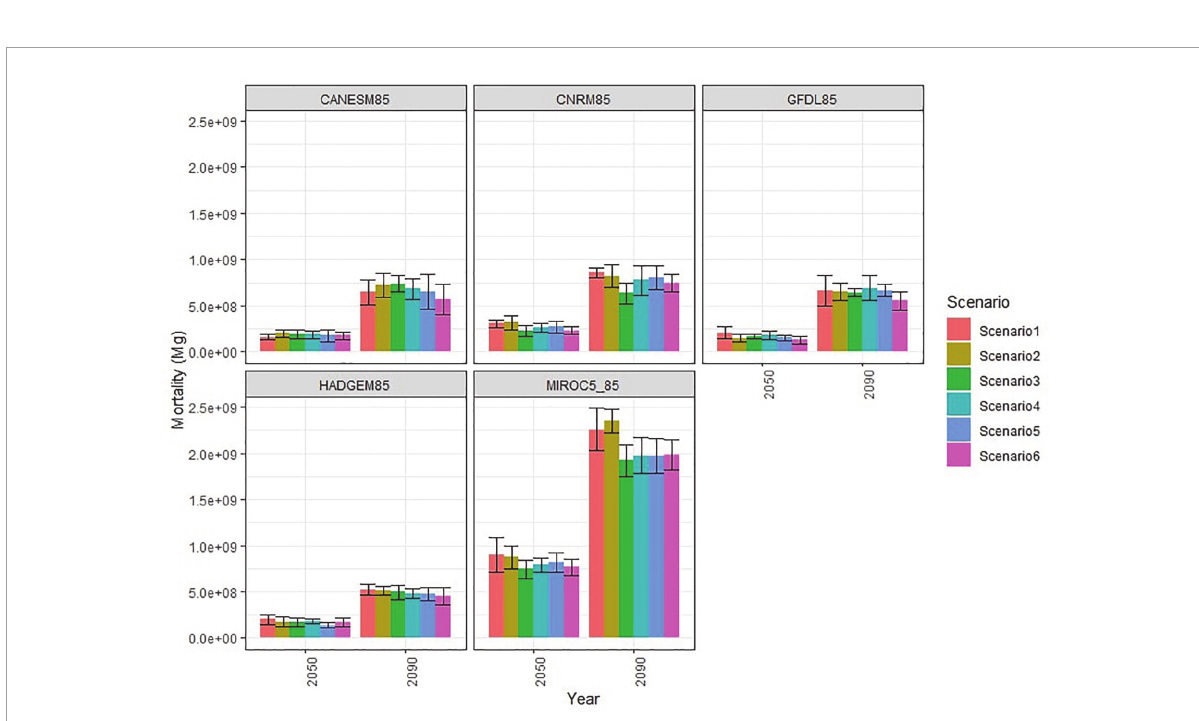
FIGURE4 Cumulative fire mortality, in megagrams of biomass, in model years 2050 and 2090. Error bars represent ± 1 standard deviation among the model replicates.